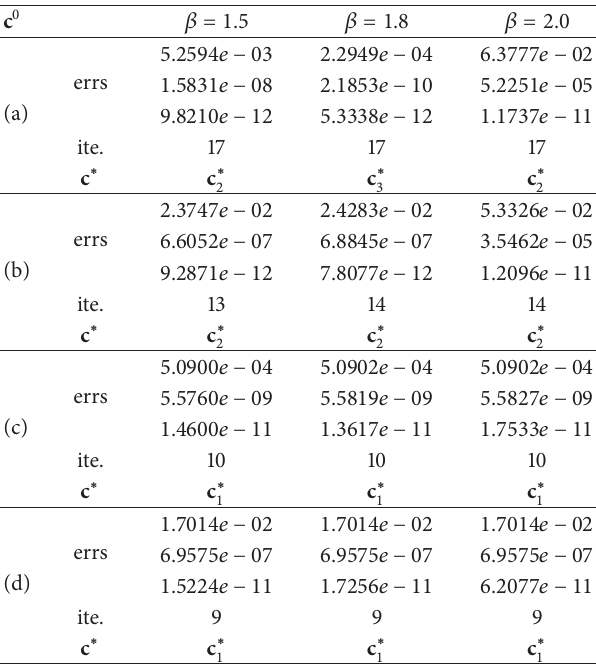
Table 3: Numerical results for Example